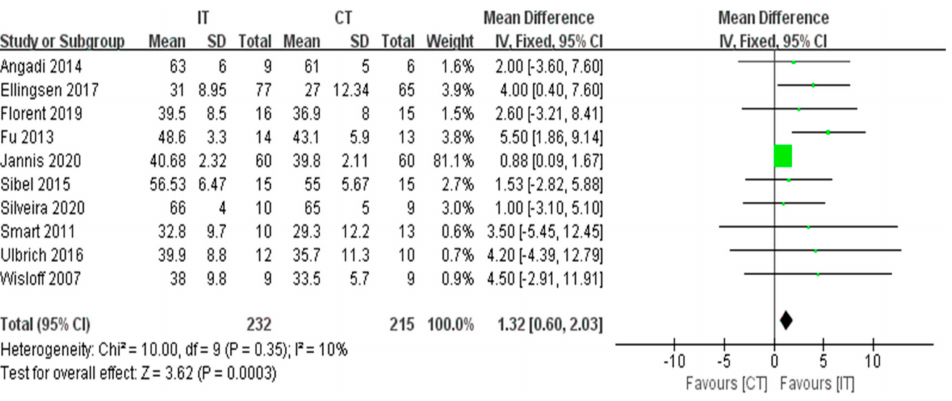
Figure 6. Forest plot: Effects of